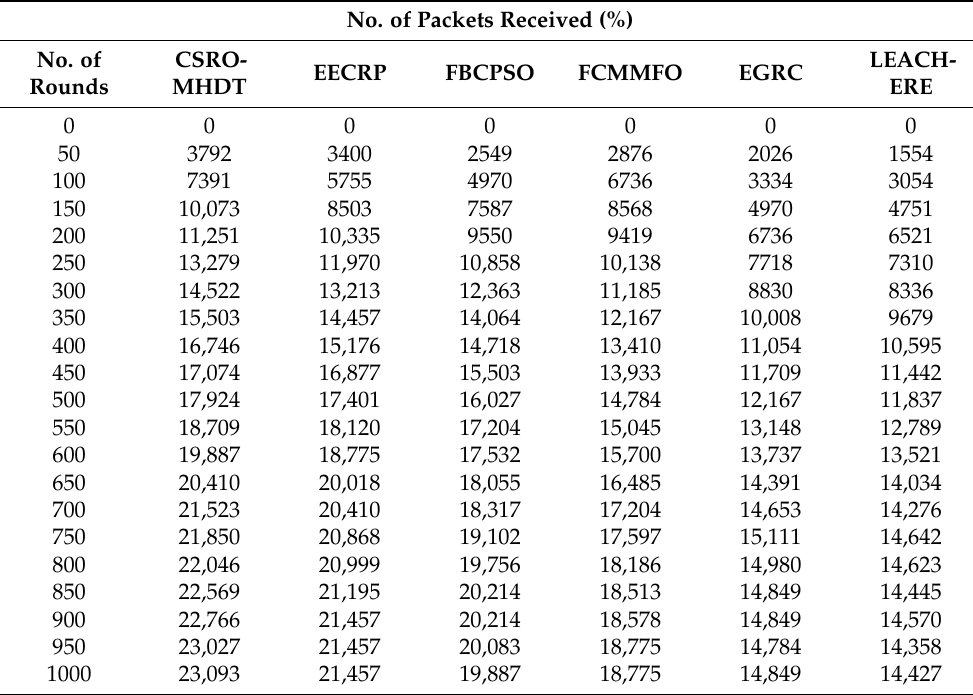
Table 6. NPR analysis of the CSRO-MHDT technique in comparison with existing approaches.